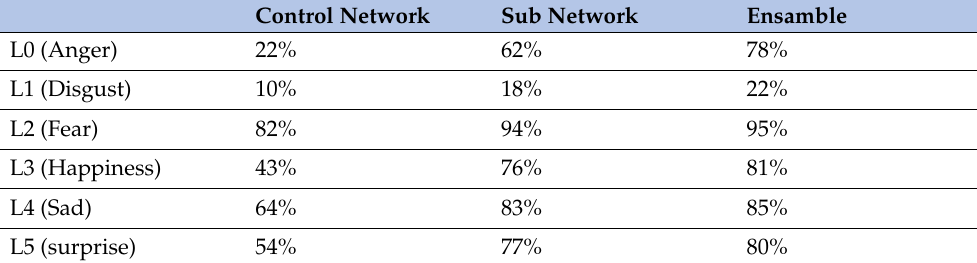
Table 3. Success